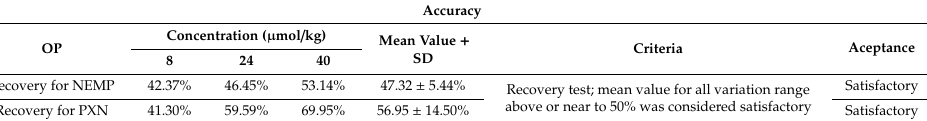
Table 5. Accuracy and recovery test results.